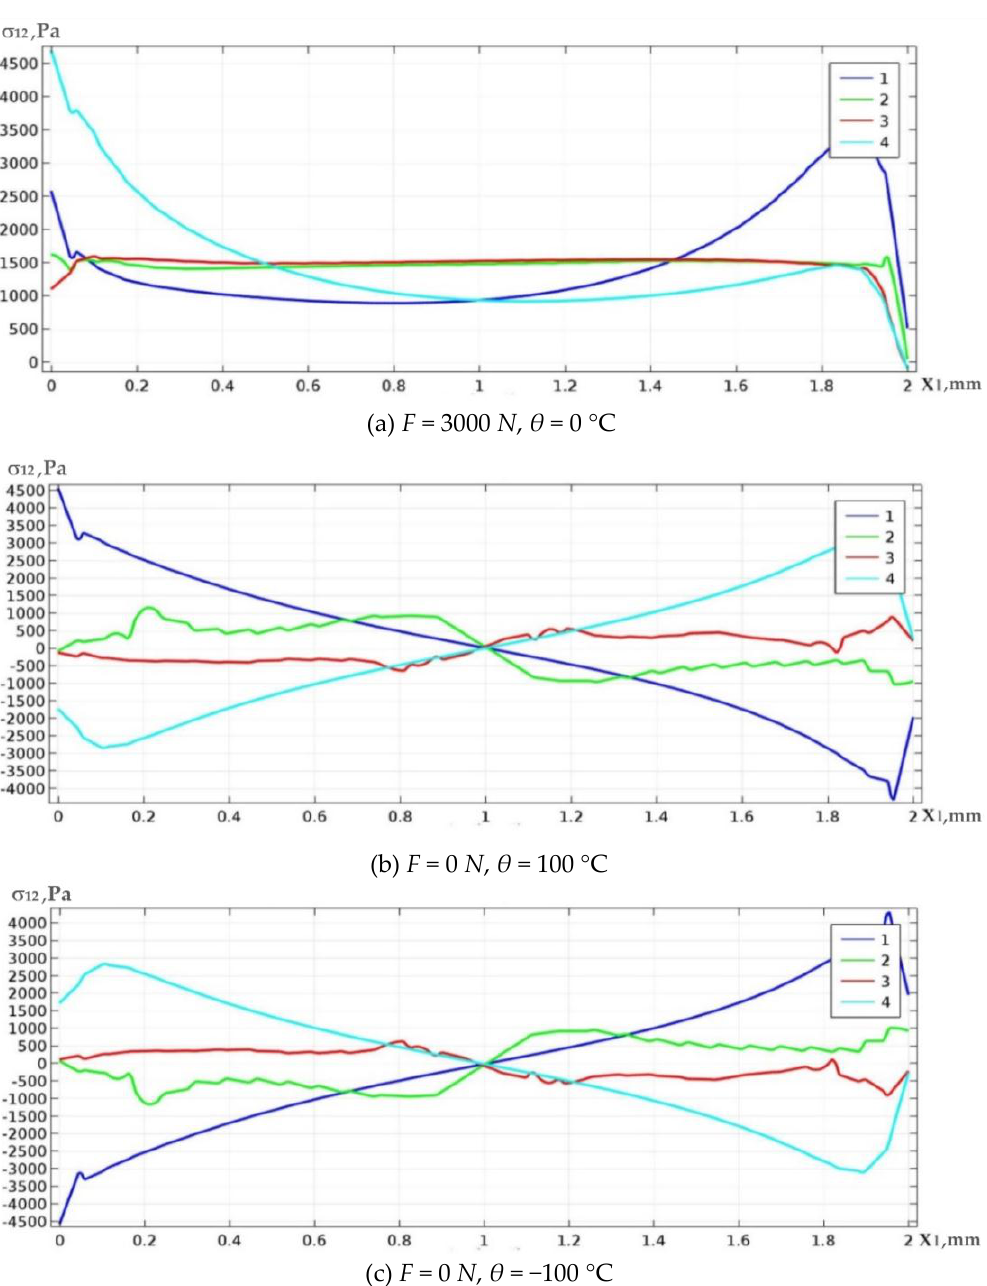
Figure 11. Graphs of the shear stress distribution along upper (1, 2) and bottom (3, 4) boundary of the solder layer under mechanical ( a ) and thermal ( b , c ) load.